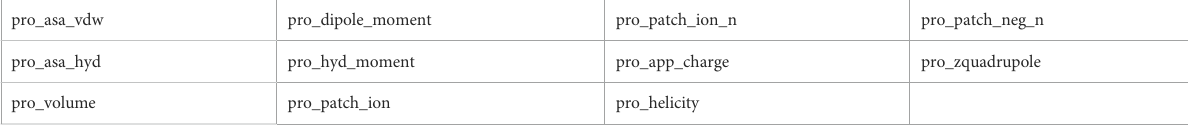
TABLE 2 11 features out of 50 were selected having a feature score of four using the feature scoring table for ADORA2A.